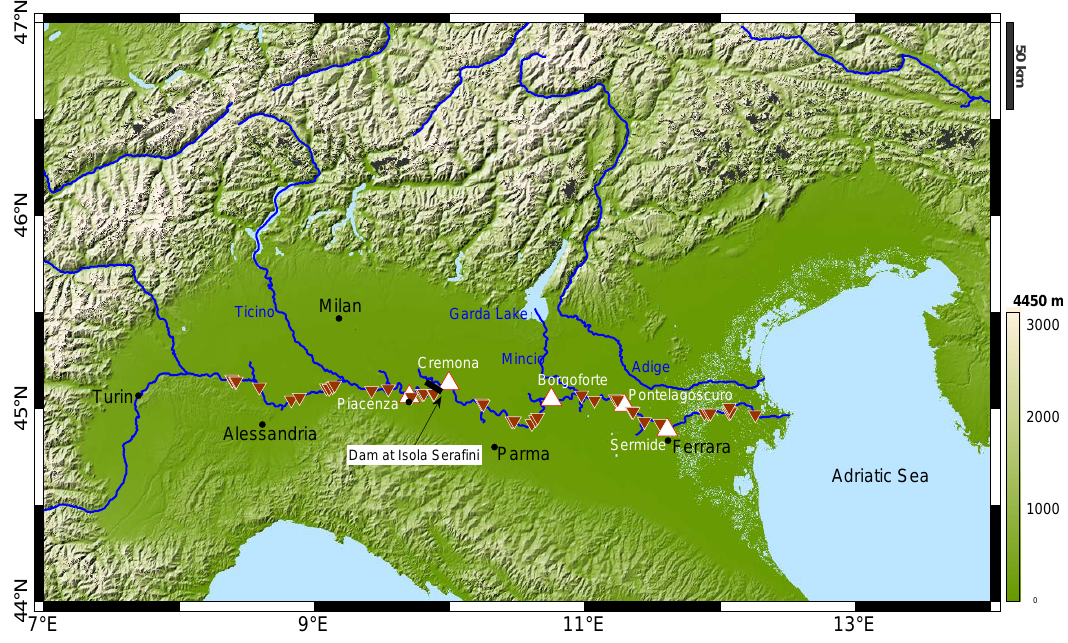
Figure 3. The Po River flowing eastward in Italy. The red triangles indicate the location of virtual stations and the white ones the location of gauging stations from west to east: Piacenza, Cremona, Borgoforte, Sermide and